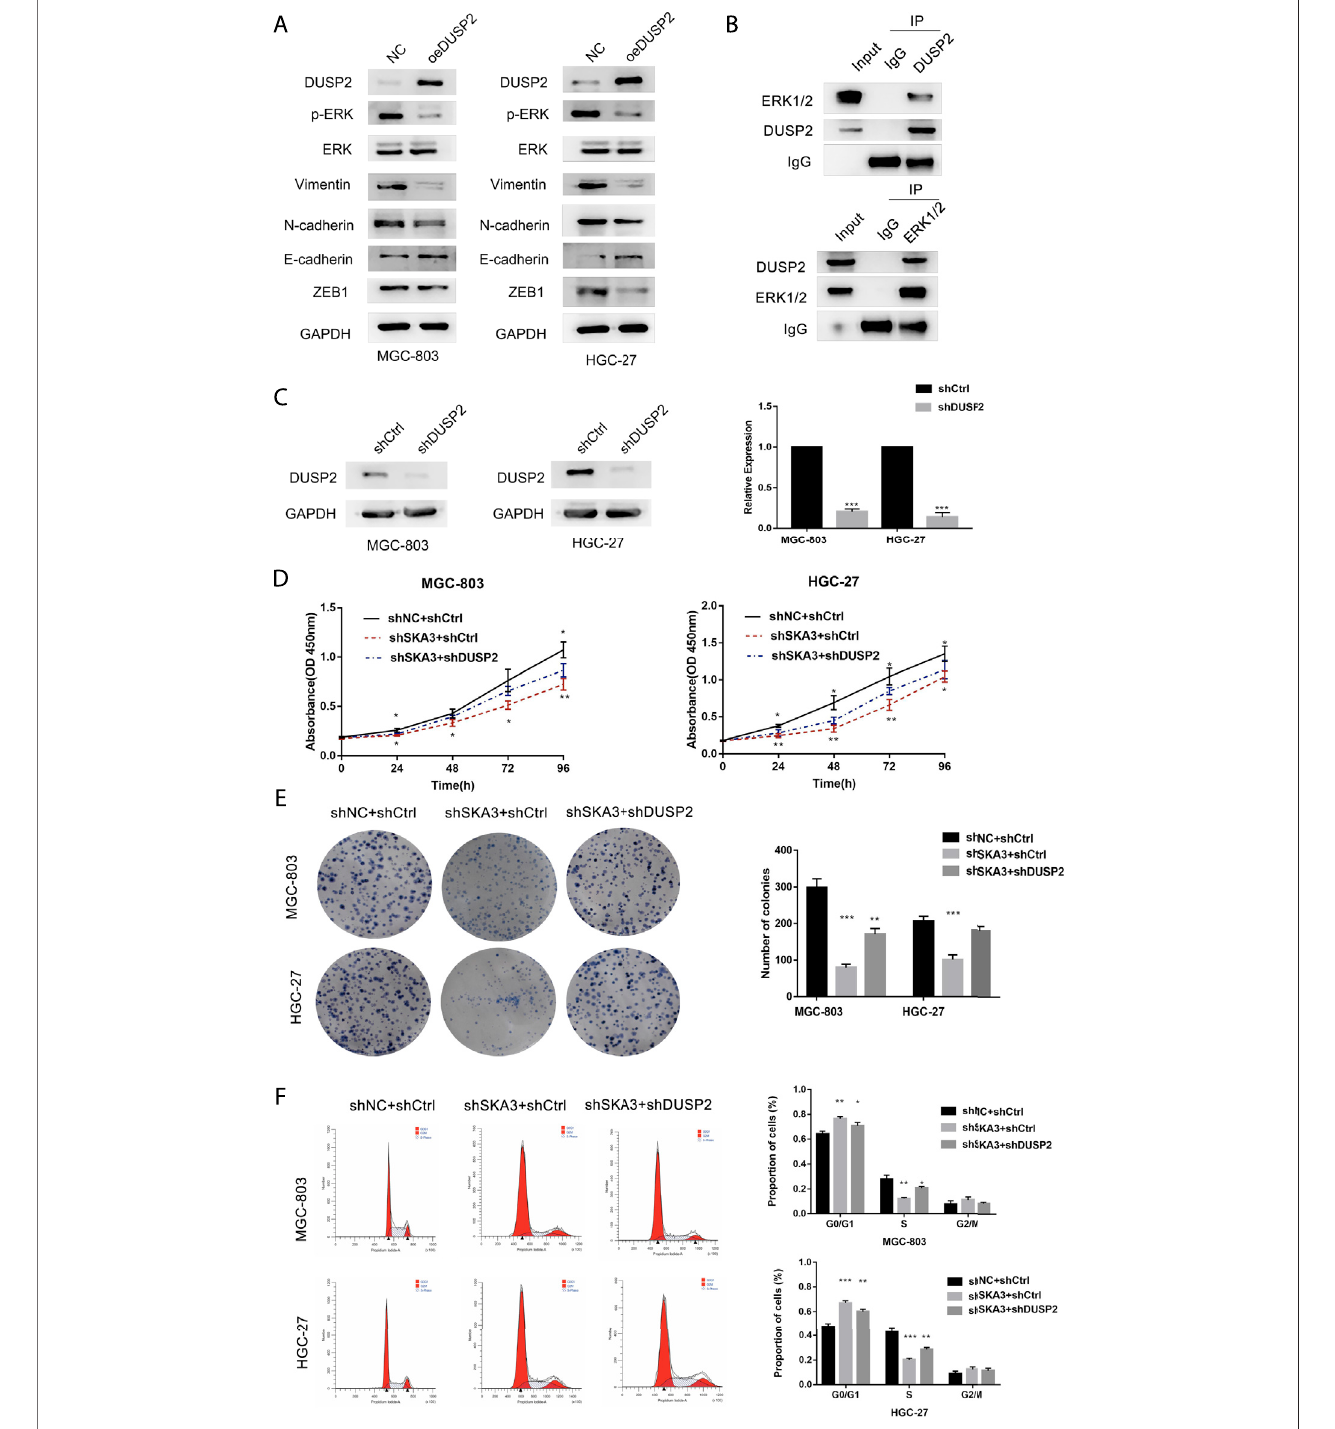
FIGURE 6 | SKA3 mediates DUSP2 induced proliferation, EMT by inactivating MAPK/ERK pathway. (A) Overexpression for DUSP2 inhibits EMT and MAPK/ERK relatedproteinsinMGC-803andHGC-27. (B) HGC-27celltotallysateswereIPwiththeDUSP2antibodiesorERK1/2antibodies,followedbyWesternblottingusingthe indicated antibodies. (C) . mRNA and protein levels of DUSP2 after transfection with shDUSP2 lentivirus in MGC-803 and HGC-27. (D) The inhibiting effect of SKA3 downregulation on MGC-803 and HGC-27 CCK-8 cell proliferation was rescued by shDUSP2 transfection. (E) The inhibiting effect of SKA3 downregulation on MGC-803andHGC-27CCK-8cellcloningwasrescuedbyshDUSP2transfection. (F) TheinhibitingeffectofSKA3downregulationonMGC-803andHGC-27cellcycle was rescued by shDUSP2 transfection. Data are shown as mean ± SD for triplicate experiments. The two-tailed Student ’ s unpaired t -test was used. * p < 0.05, ** p < 0.01, *** p <